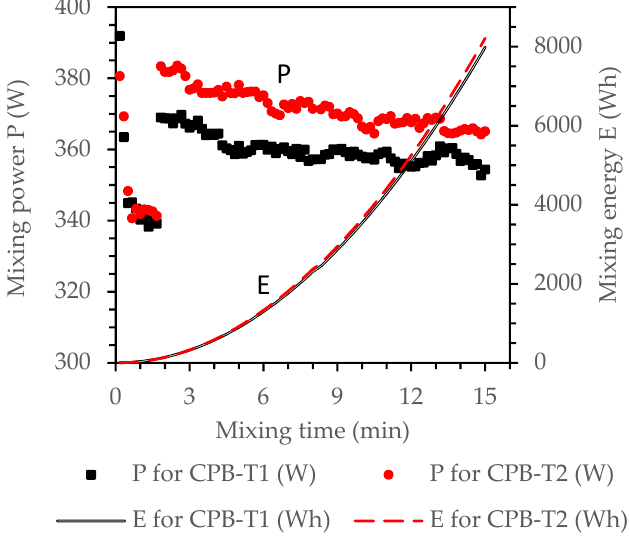
Figure 5. Variation in power consumption P(t) and dissipated energy E(t) with respect to running time t for the preparation of mixtures M04 and M20 made with tailings T1 (CPB-T1) and T2 (CPB-T2), respectively (see mixing parameters in Table 4).